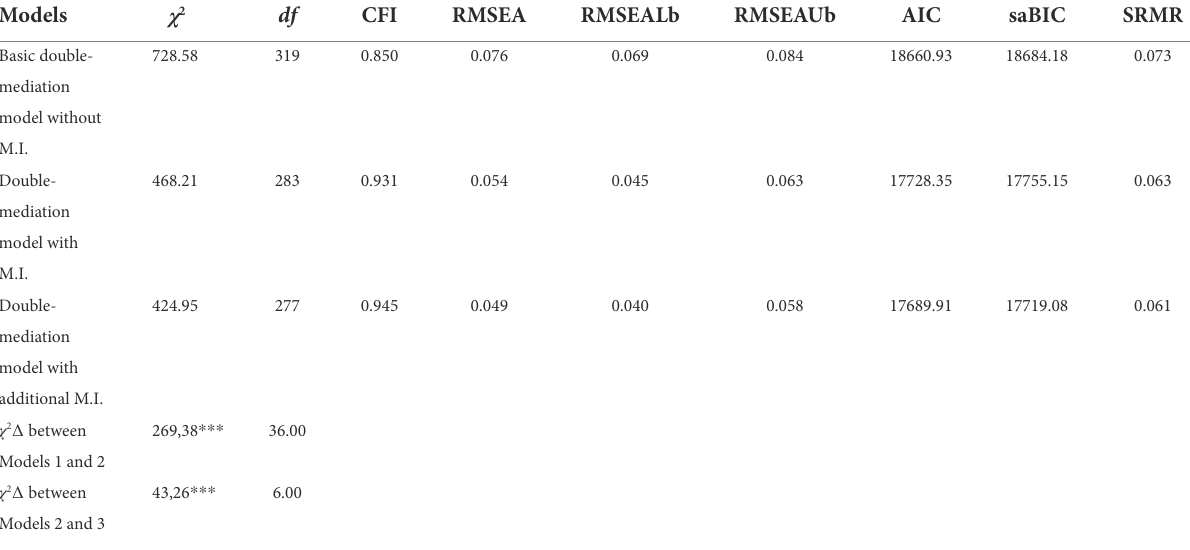
TABLE 3 Positive identity modelling tested through SEM with confidence and character as mediators in Chilean